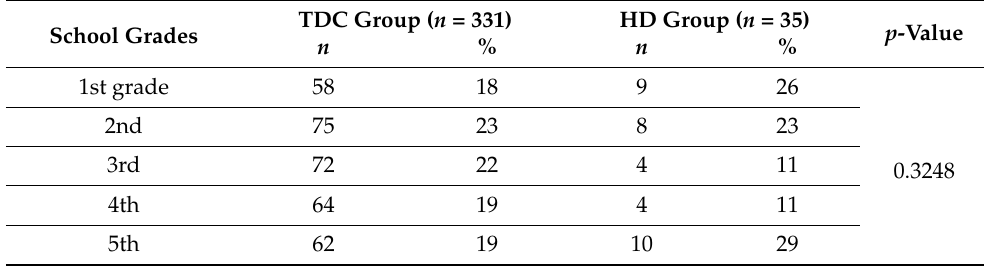
Table 2. School grades in HD group vs. TDC